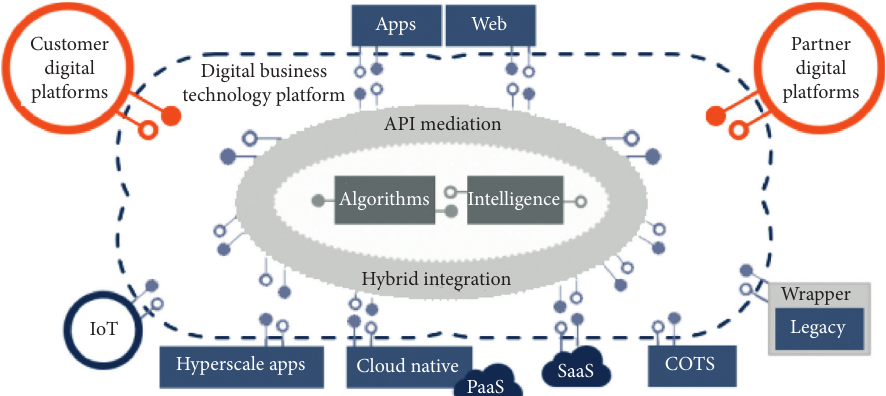
Figure 3: Physical architecture of the resource and service trading platform.